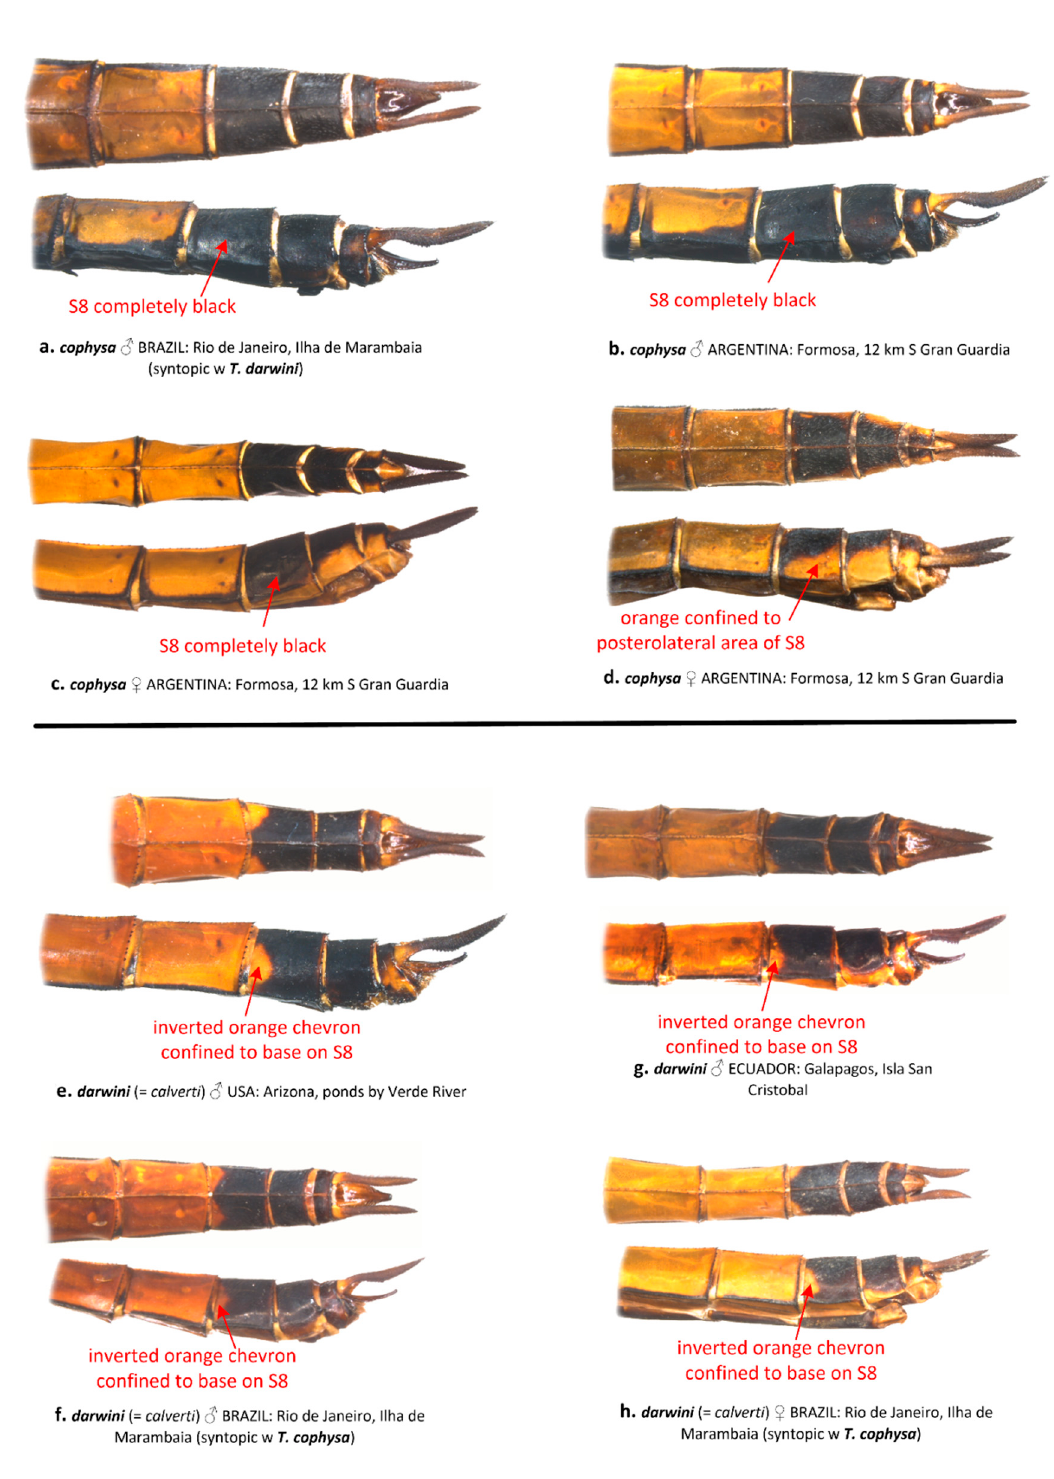
Figure 7. Dorsal and lateral views of abdominal segments S7-10 from T. cophysa ( a – d ) and T. darwini (senior synonym of T. calverti , stat. rev.) ( e – h ).